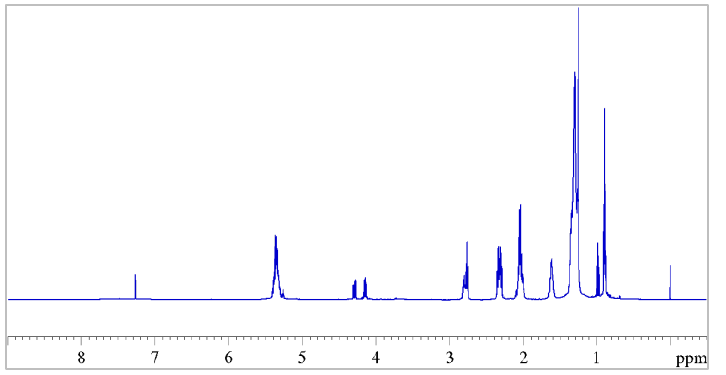
Figure 3. 1 H NMR spectrum (500 MHz) of hemp seed oil dissolved in CDCl 3 recorder at 298K, obtained with ultrasound-assisted extraction (UAE) procedure.